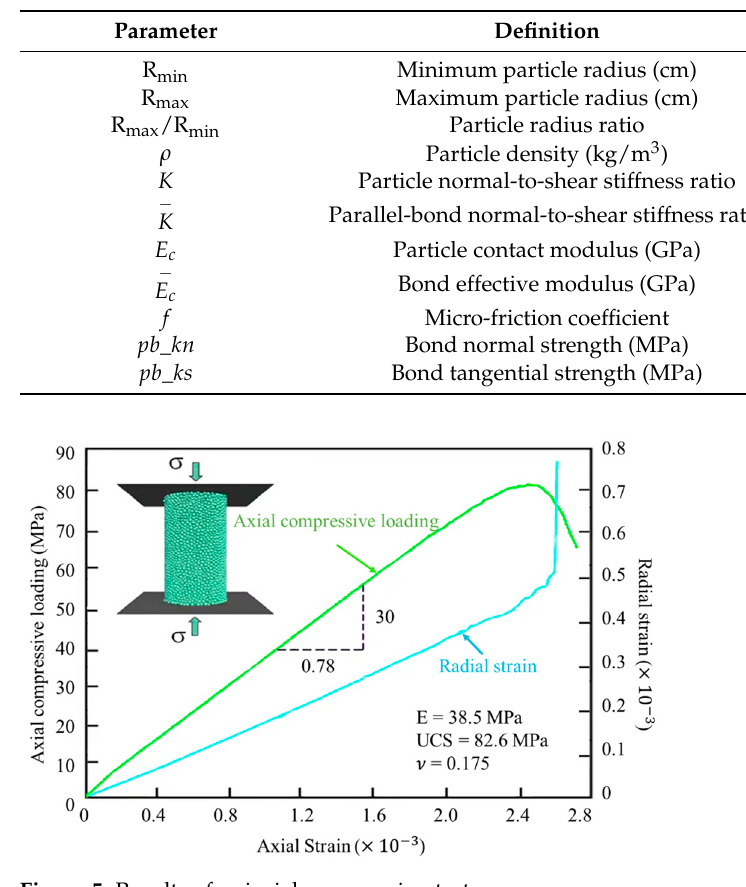
Figure 5. Results of uniaxial compression test. Table 1. Micro-strength parameters of the PFC 3D model.